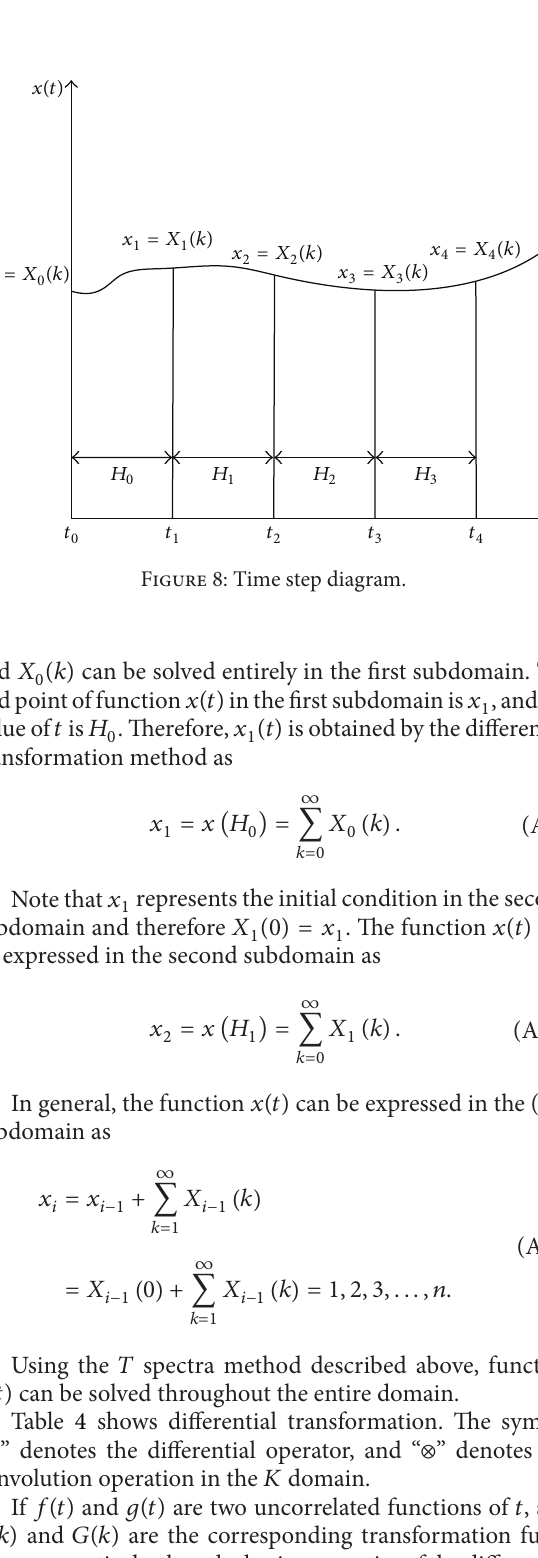
Table 4: Operation in the 𝐾 domain with 𝑀(𝑘) =